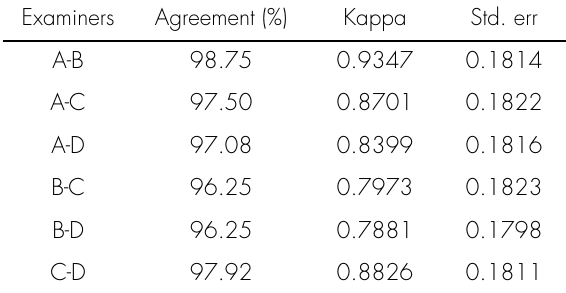
Table IV. Inter-examiner agreement and Kappa of the IOTN-DHC for the study models. Examiners